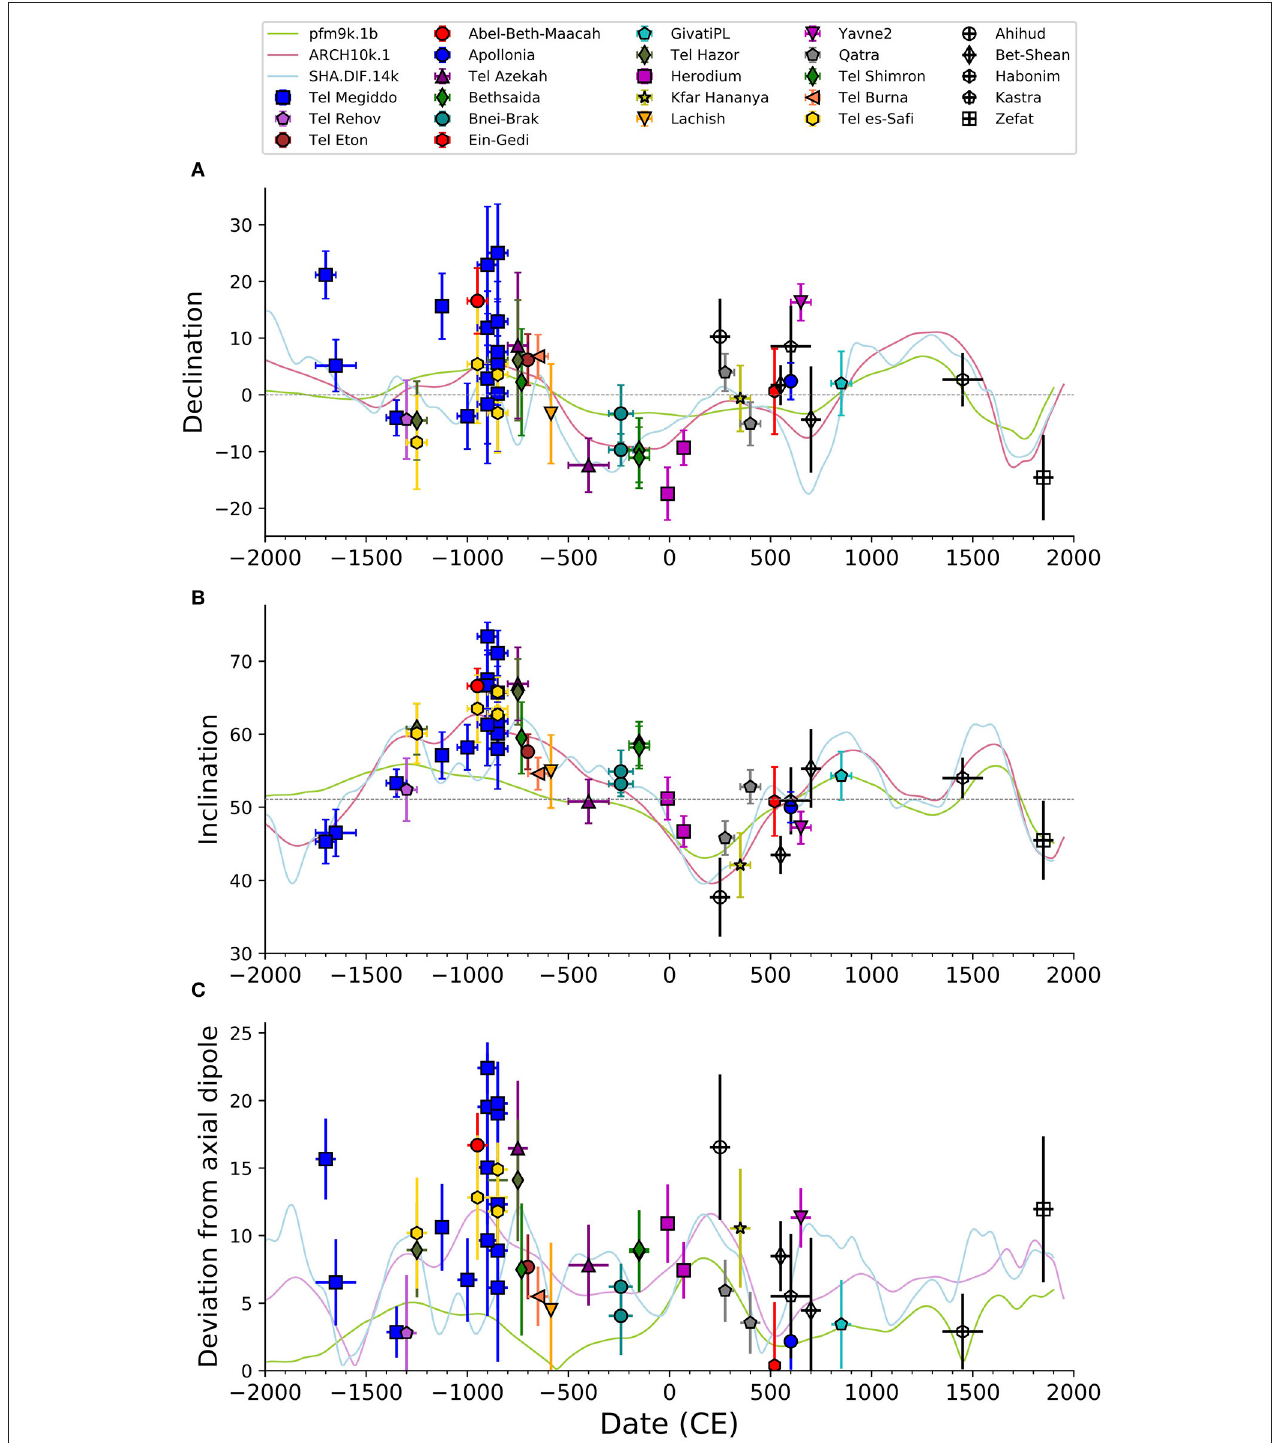
FIGURE 3 | Archaeomagnetic directions of sites that passed acceptance criteria ( Tables 2 , 3 ) relocated to Jerusalem. (A) Declination. (B) Inclination. (C) Angle between the archaeomagnetic direction and a geocentric axial dipole field. Lines show predictions of global geomagnetic models [(Nilsson et al., 2014; Pavon-Carrasco et al., 2014; Constable et al., 2016)]. Locations of sites map is shown in Figure 1 . The highest inclinations, declinations and azimuthal deviations from axial dipole occurred in the ninth century during the Levantine Iron Age Anomaly ( Figure 5 ).